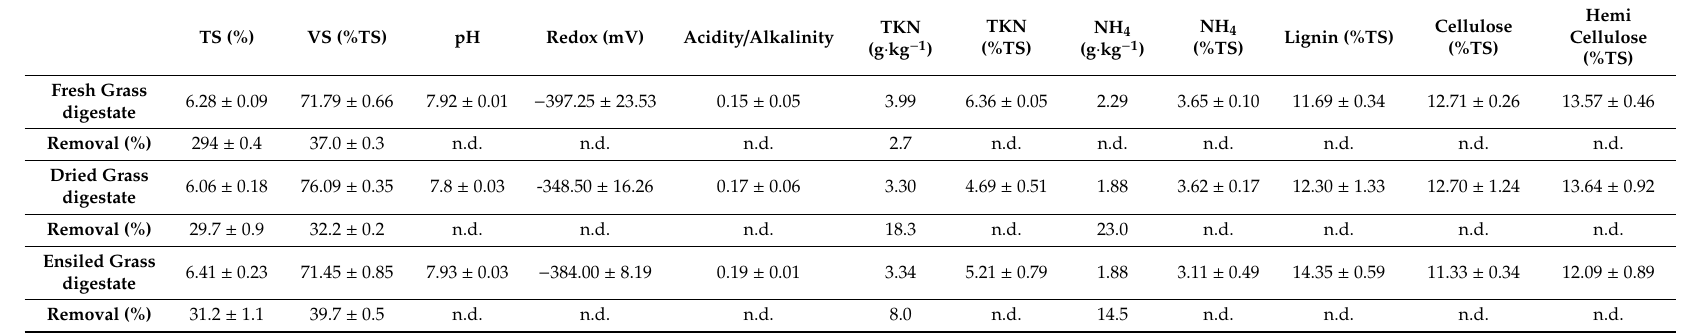
Table 2. Characteristics of digestate from the tests (n.d. indicates not